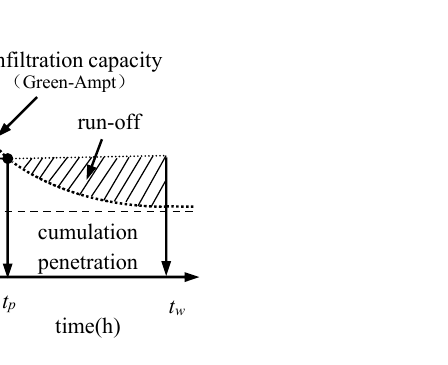
Figure 3. Sketch map of rainfall seepage (modified according to Mein and larson